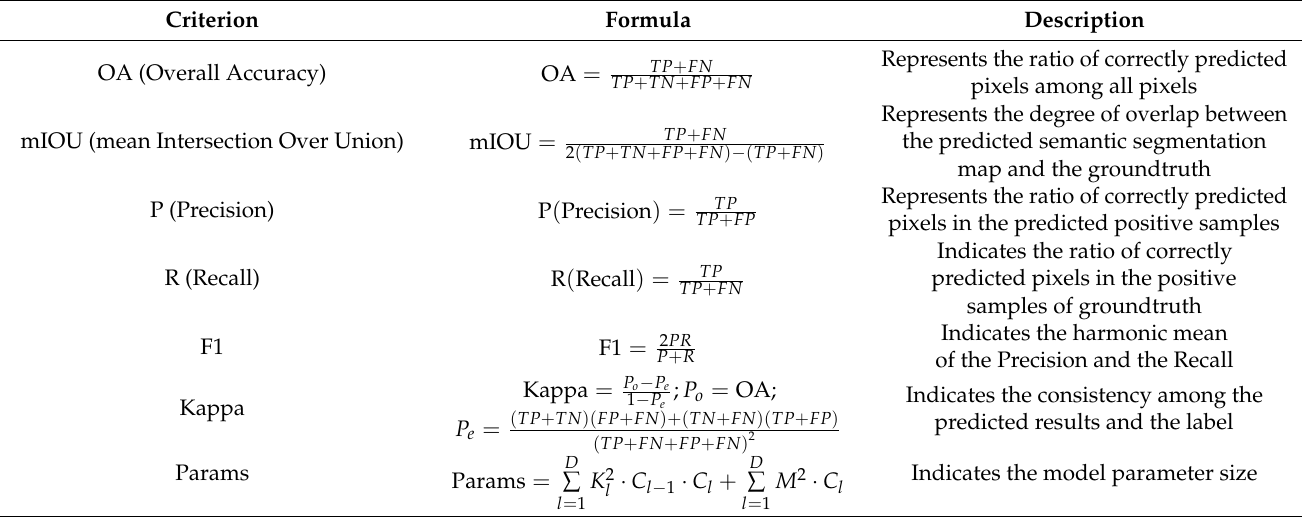
Table 4. Description of the quantitative criteria for the experiments. TP and FN indicate the number of landslide and non-landslide pixels that were correctly predicted in the prediction results, respectively. TN is the number of landslide pixels that were predicted to be backgrounds. FP indicates the number of non-landslide pixels that were predicted to be landslides. K indicates the convolutional kernel size, C represents the feature number, and M represents the feature map